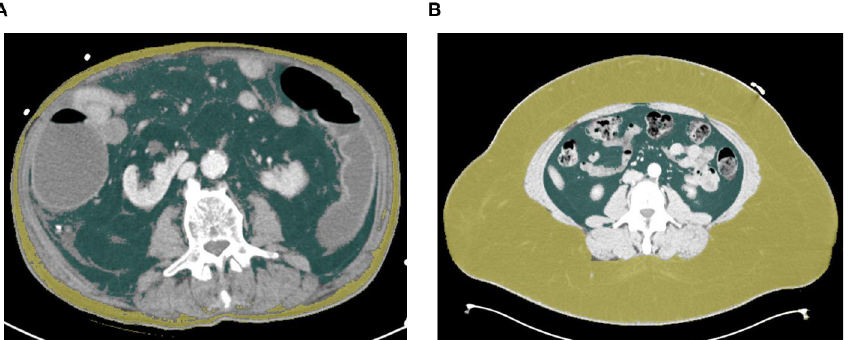
visceral (green area) and excessive subcutaneous (yellow area) adipose tissue is